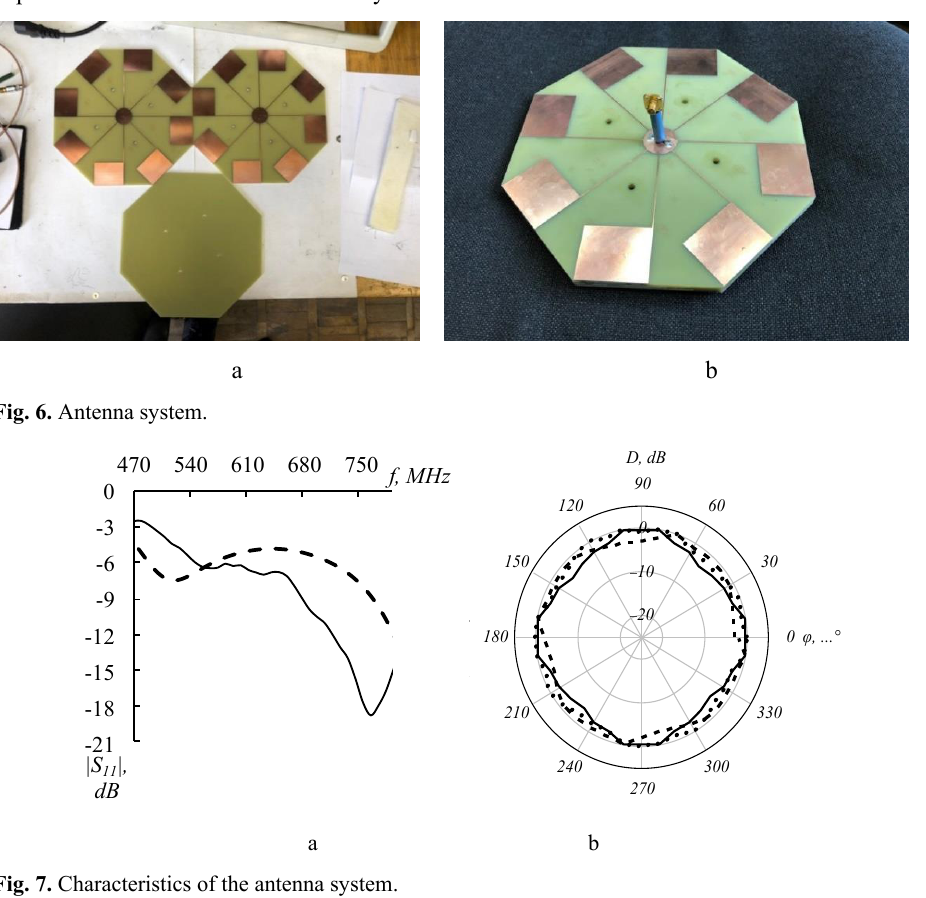
Fig. 7. Characteristics of the antenna